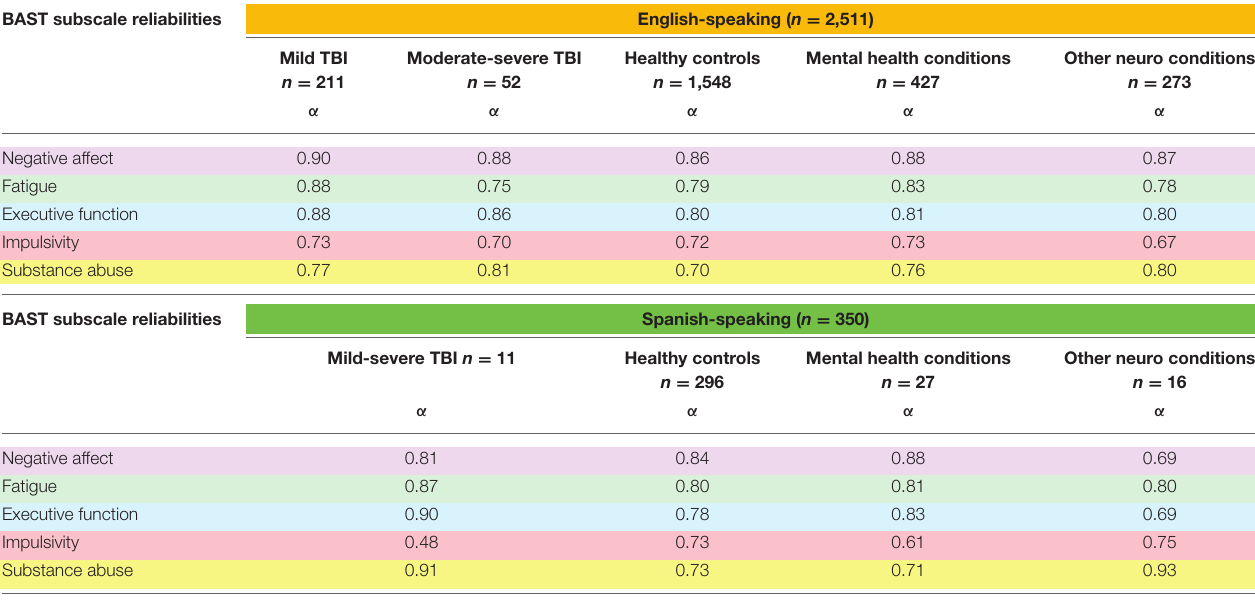
TABLE 5 | Internal consistency reliabilities of the BAST